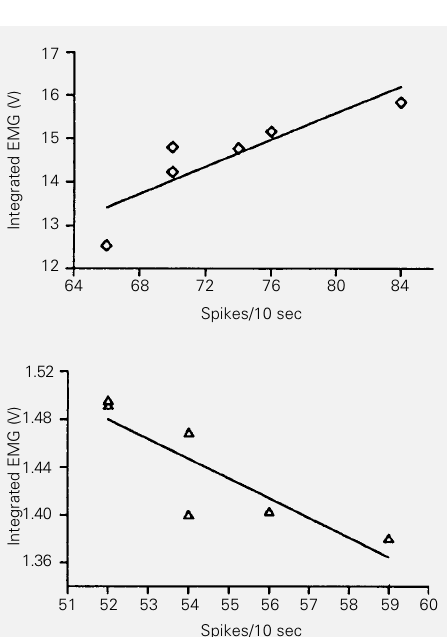
Figure 1 - Gross relationship be- tween the electrical activity of putative serotonergic neurons and the integrated electrical ac- tivity of two masticatory muscles (digastric muscle, top panel; masseter muscle, bottom panel). Two 10-sec samples were taken during each of the following be- havioral activities: quiet waking, drinking milk, licking lips and lick- ing forelimbs/washing face. ! , neuron #14041; # , neuron #24151; @ , neuron #14021; , neuron #14173; P , neuron #14194. Correlations were sig- nificant at levels from 0.02 to 0.04.